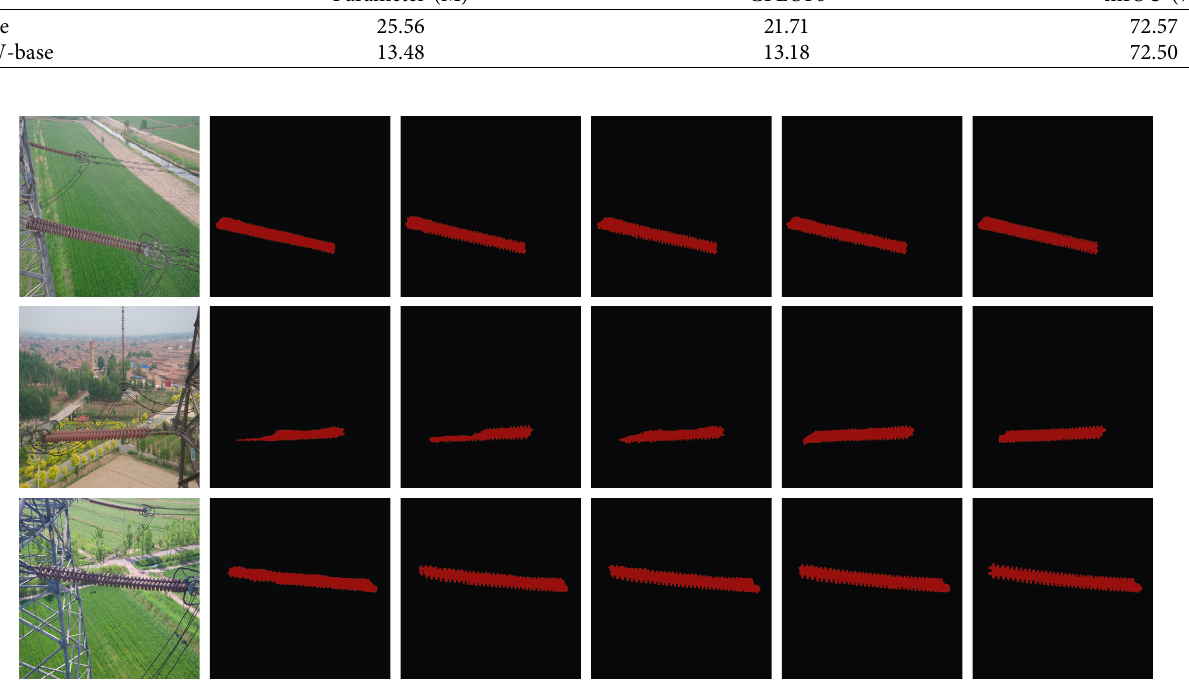
Figure 8: Examples of semantic segmentation results on insulator test dataset. (a) Original input image; (b) the predicted image of Base Module; (c) the predicted image of the former combined with CAM; (d) the predicted image of the former combined with RBM; (e) the predicted image of the former combined with AFFM; and (f) Ground